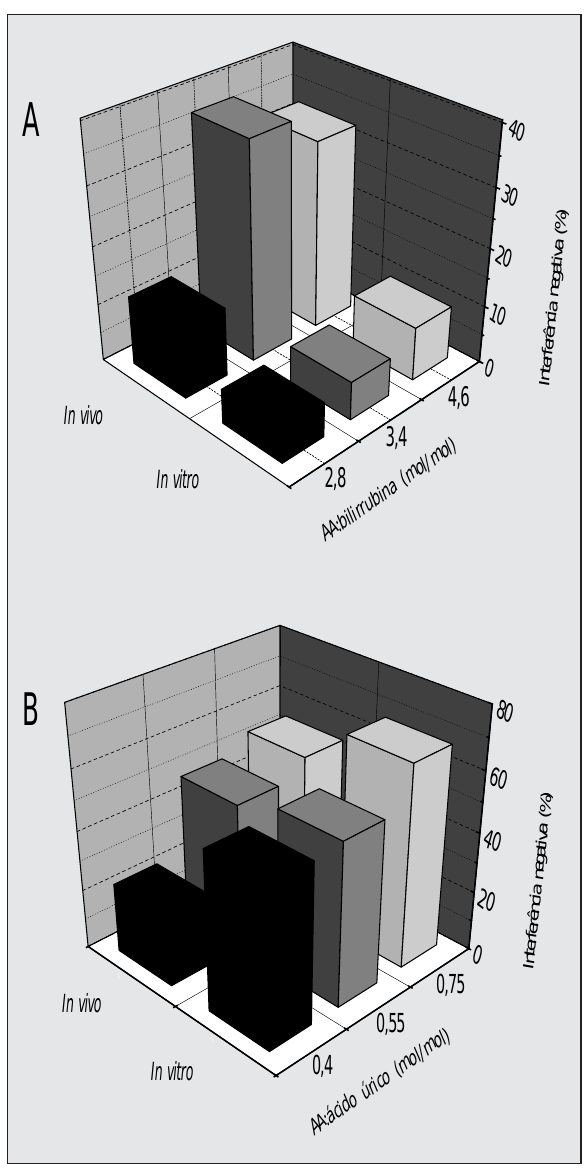
Figura 3 – Interferência negativa do ácido ascórbico na determinação de (A) bilirrubina total e (B) ácido úrico. Para efeito de comparação, os resultados obtidos 4 e 12 horas após a ingestão de vitamina C (Tabelas 1 e 2) e após a adição de ácido ascórbico ao pool de soro (Tabela 5 e Figura 2) foram normalizados em termos molares de ácido ascórbico:analito